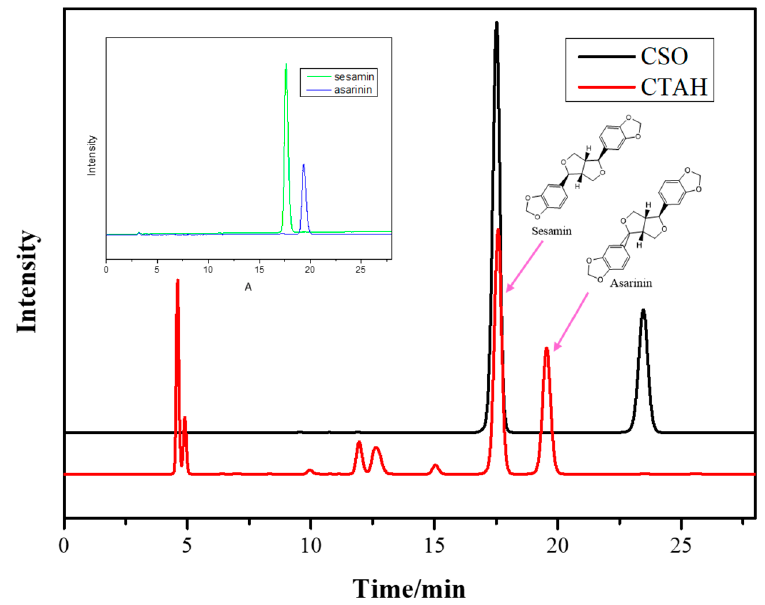
Figure 2. HPLC-UV chromatogram of the standard substance (A); cold-pressed sesame oil (CSO) and CSO were treated with citric acid loaded on H β (CTAH). Detection wavelength, 287 nm. Retention times and chemical structures of sesamin and asarinin in sesame oil are displayed.